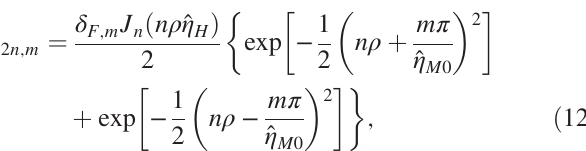
FIG. 4. Same as Fig. 3(a), but with (a) ˆ η M 0 ¼ 0 . 1 and (b) ˆ η M 0 ¼ 2 . In both cases, ˆ η M ¼ ˆ η M 0